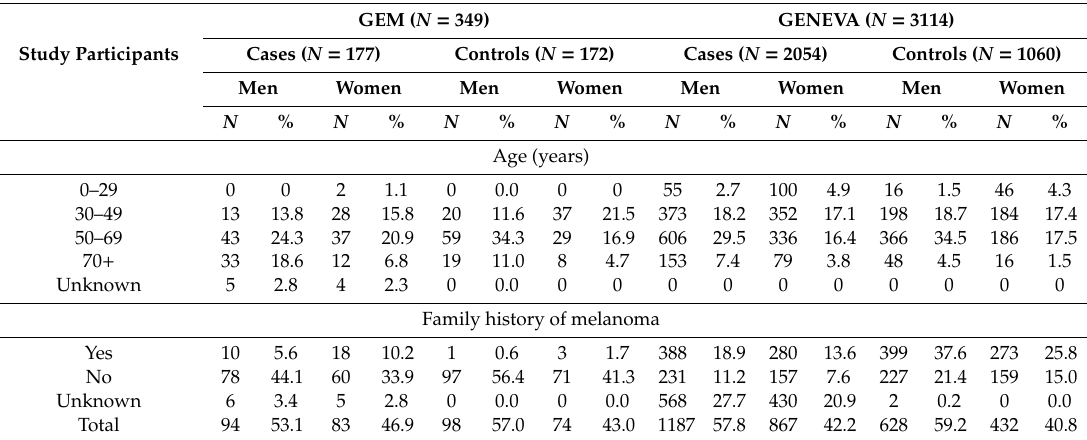
Table 1. Characteristics of the study